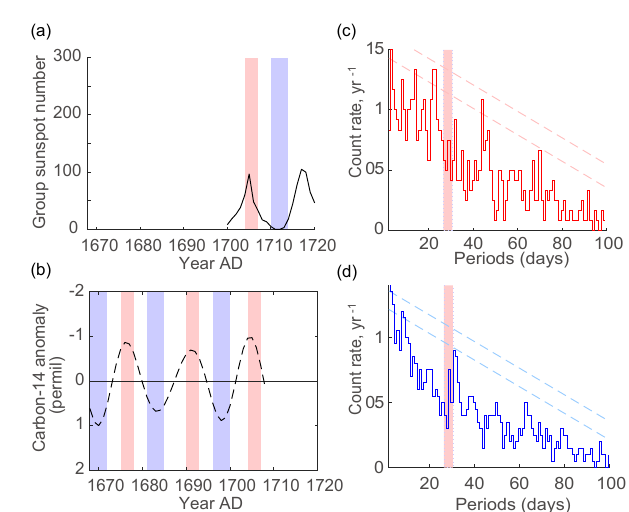
Figure 4. (a) Group sunspot numbers around the latter half of the Maunder Minimum. (b) Solar cycles reconstructed from the carbon- 14 content in tree rings. The red and blue shading denotes the pe- riods of solar maxima and minima, respectively, used in the anal- yses. (c) Periodicity of lightning events during the solar maxima shown in panel (b) . The red dashed lines denote 2 and 3SD during the solar maxima, and the red shaded bar indicates the 27–30-day period. (d) Same as in panel (c) but for solar minima.